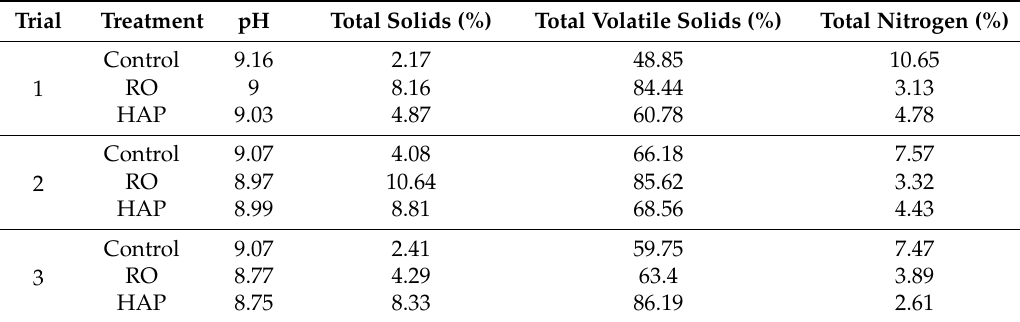
Table 3. Physical properties of manure after trials, control, RO, & HAP-treated